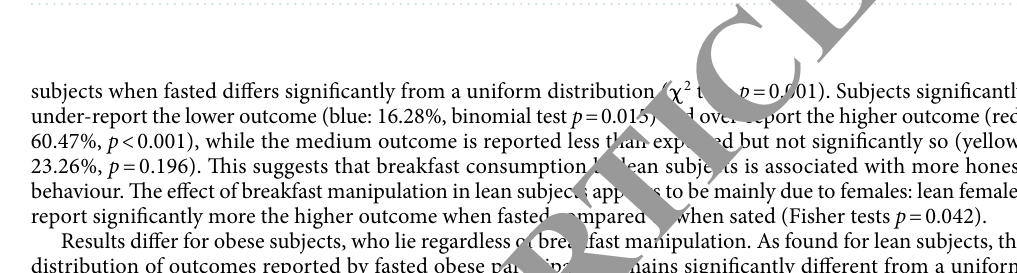
Table 2. Average payoffs expressed in euros for sated and fasted subjects, by BMI status and gender. Standard deviation in